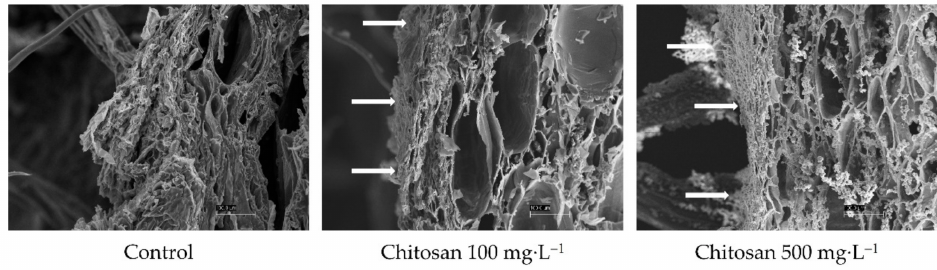
Figure 7. Scanning electron micrographs (SEMs) of preharvest chitosan-treated and untreated ‘Garmrok’ kiwifruit peel surfaces. The arrows indicate the chitosan film on kiwifruit peel after coating. All micrographs are at 500X and the scale bars in each image represent the lengths of 100 µ